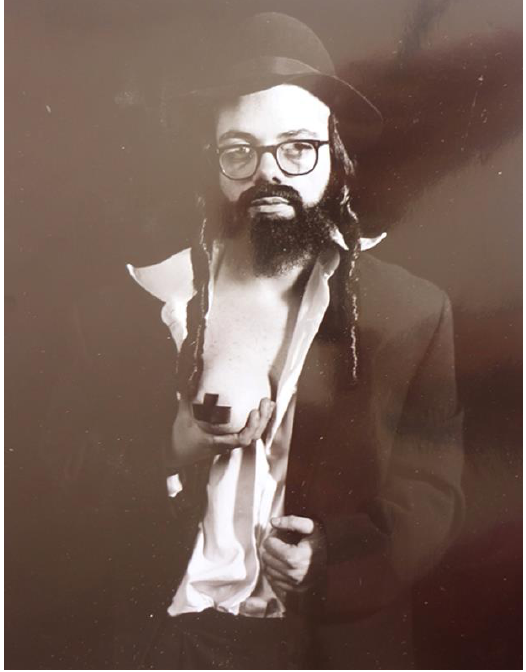
Figure 8. Oreet Ashery, Marcus Fisher I , circa 1998. Courtesy of the artist.